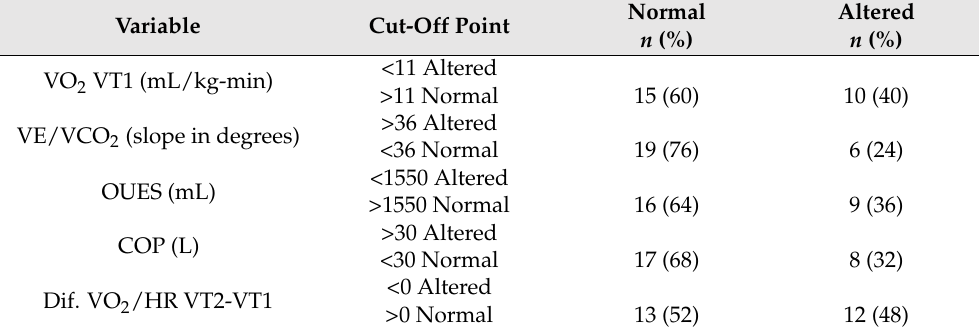
Table 3. Sub-maximum variables were “altered” when under the cut-off point for variables. Variable Cut-Off